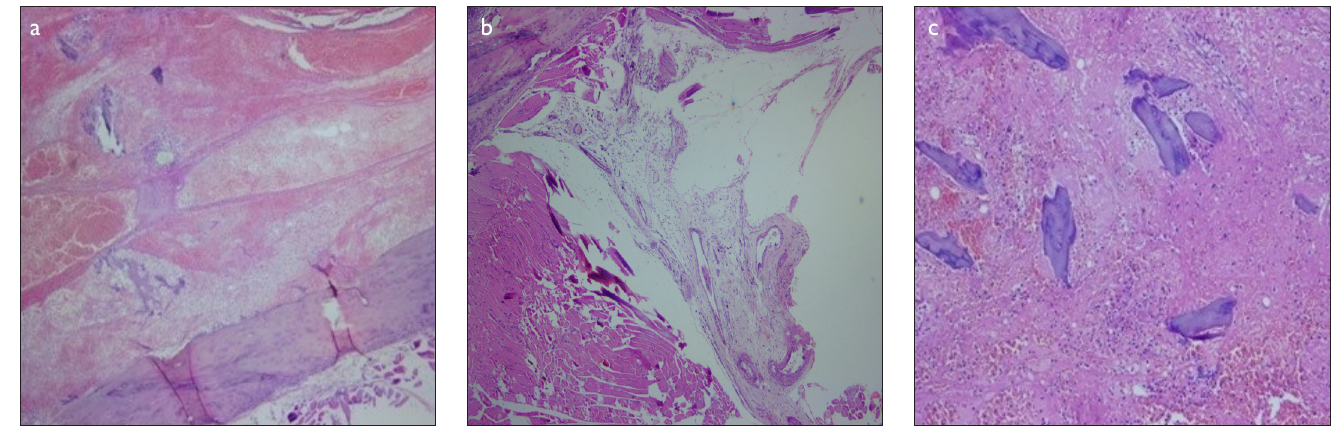
Figure 2. a-c. Hematoxylin-eosin staining of bone marrow inflammation (20x magnification). (a) Saline, (b) 0.5% NaOCl, and (c) 5% NaOCl